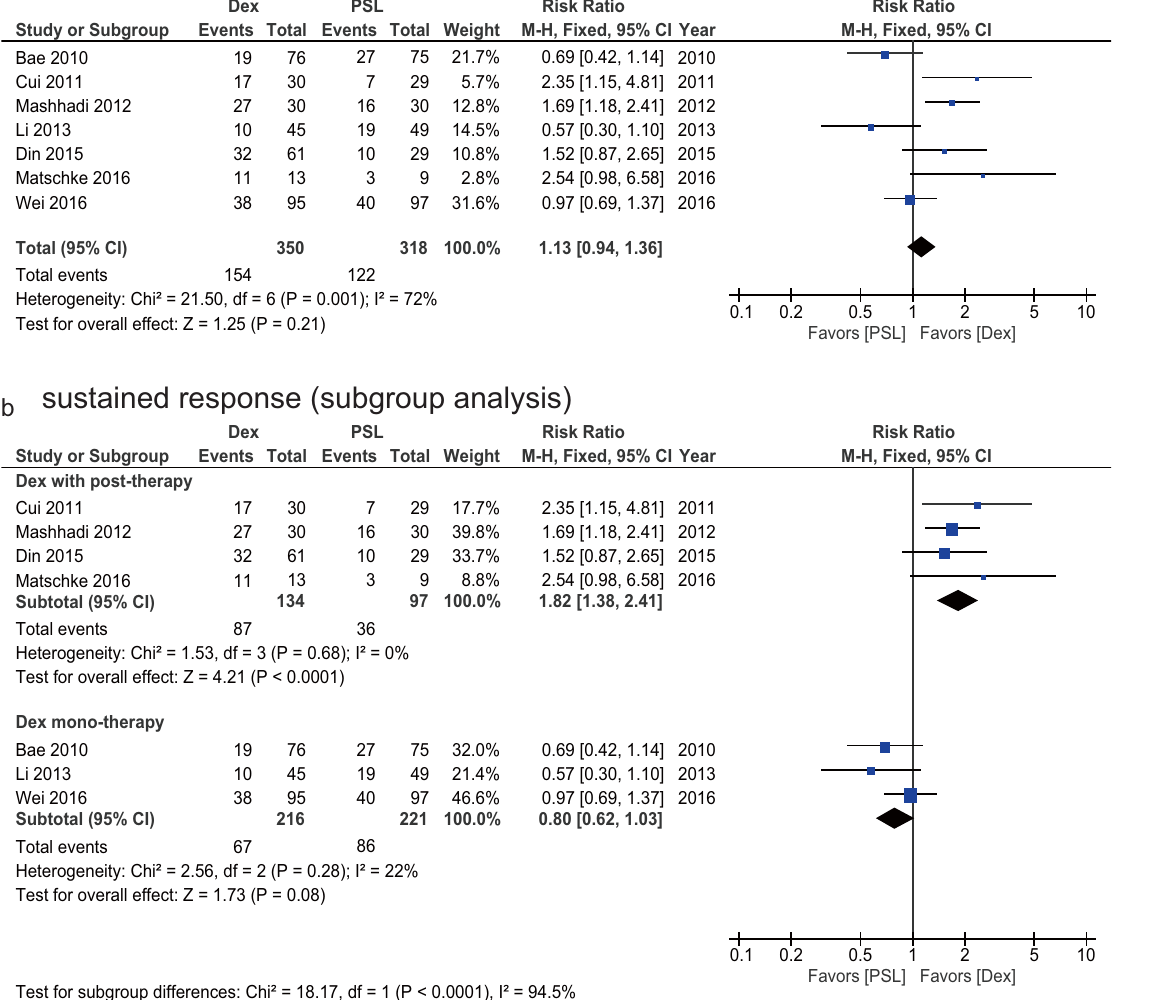
Fig. 1 Forest plots of long-term sustained response (SR) comparison. The summary effect estimate (risk ratio [RR] of SR at 6 months; platelet counts > 30 (cid:1) 10 9 /L) for individual randomized controlled trials (RCTs; dexamethasone [Dex] vs. prednisolone [PSL]) are indicated with black boxes (theirsizesareproportionaltothestudyweight),withthelinesindicating95%con fi denceintervals(CIs).Theoverallsummaryeffectestimate(RR)and95% CI are indicated by the diamond below. ( a ) SR in all the RCTs and ( b ) subgroup analyses (Dex with posttherapy and Dex